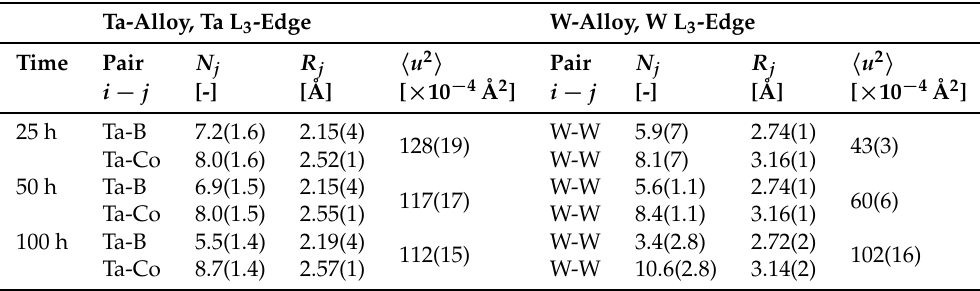
Table 4. Numerical results of fitting EXAFS data based on the first coordination shell model from measurements performed at the Ta L 3 and W L 3 edges. The scatterer–absorber pairs are indicated, the partial coordination number N j , the path length R j and the mean square atomic displacement (cid:104) u 2 (cid:105) for all relevant samples are